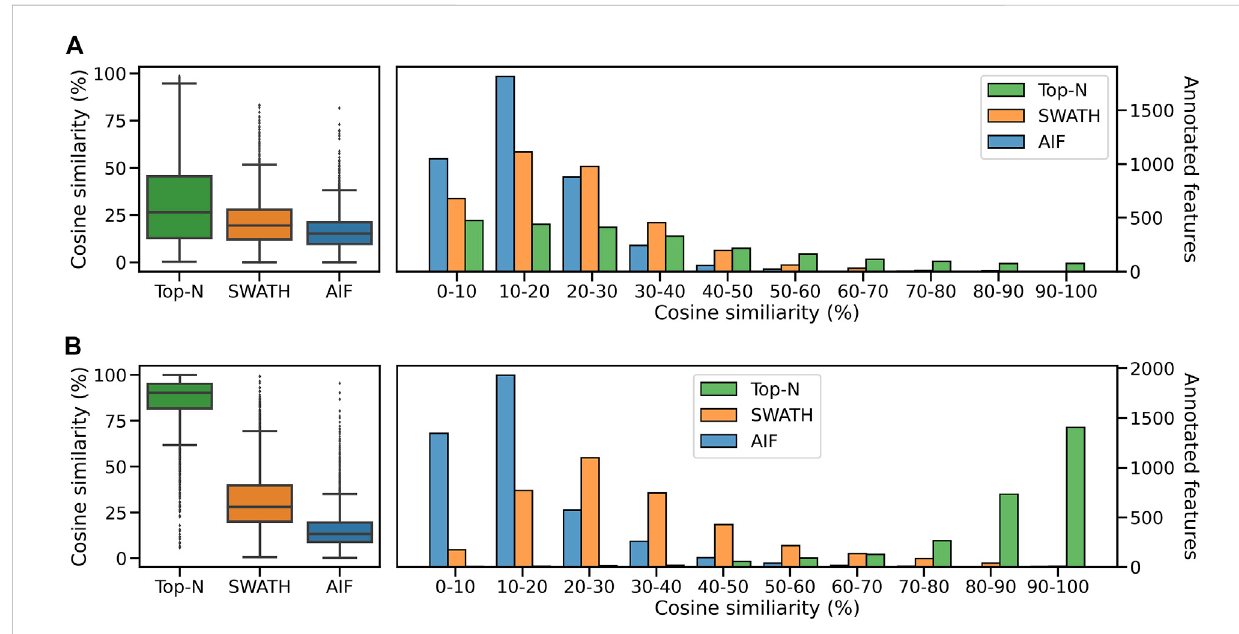
FIGURE 8 Distribution of cosine similarity of annotated features for Top-N and DIA methods for the (A) GNPS/NIST14 library and (B) Multi-Injection library.